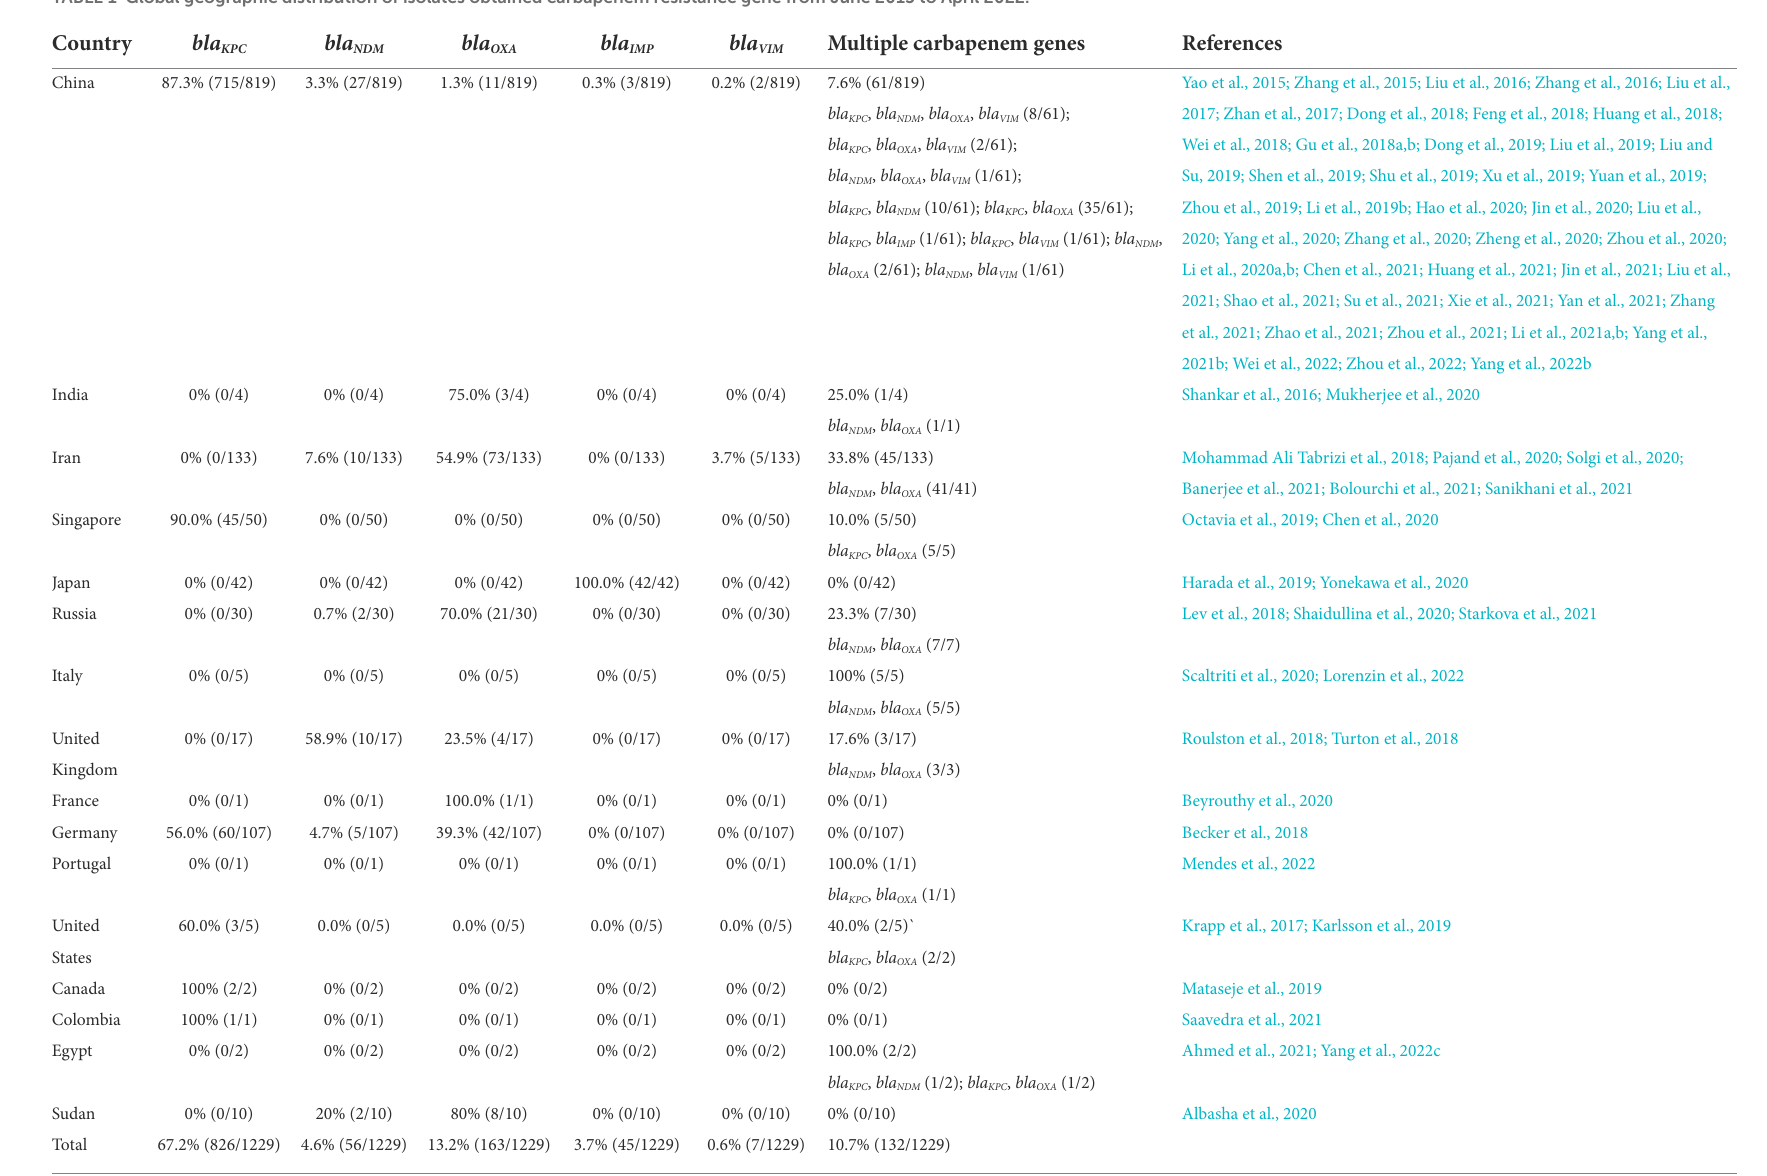
TABLE 1 Global geographic distribution of isolates obtained carbapenem resistance gene from June 2015 to April 2022.